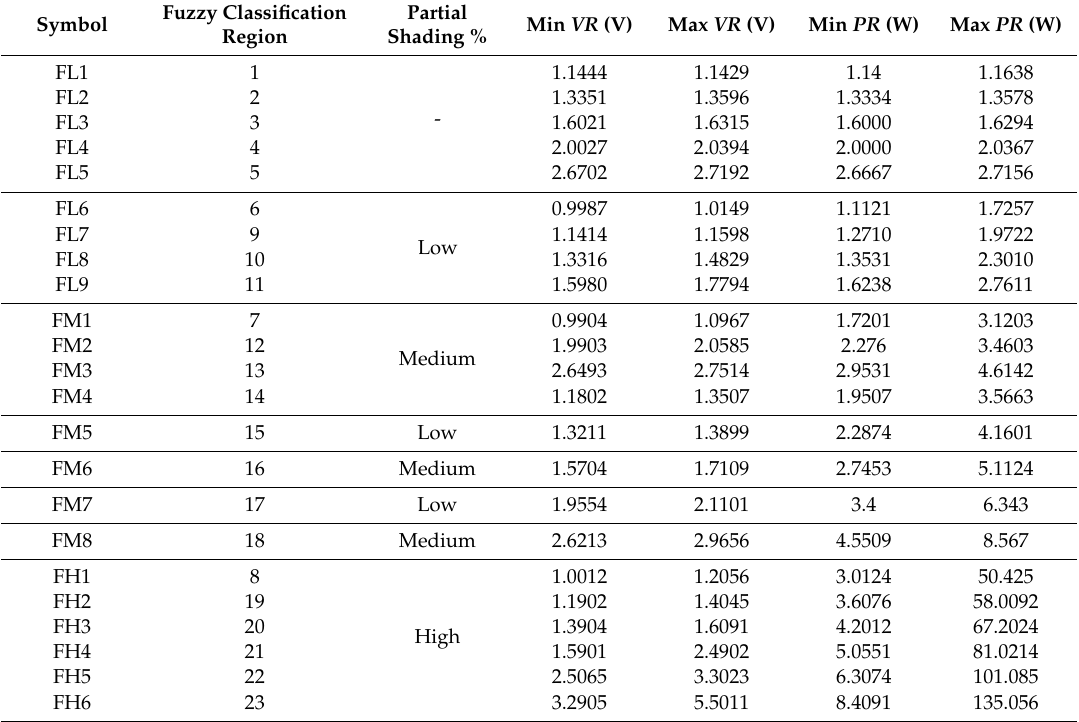
Table 3. Fuzzy logic input regions.